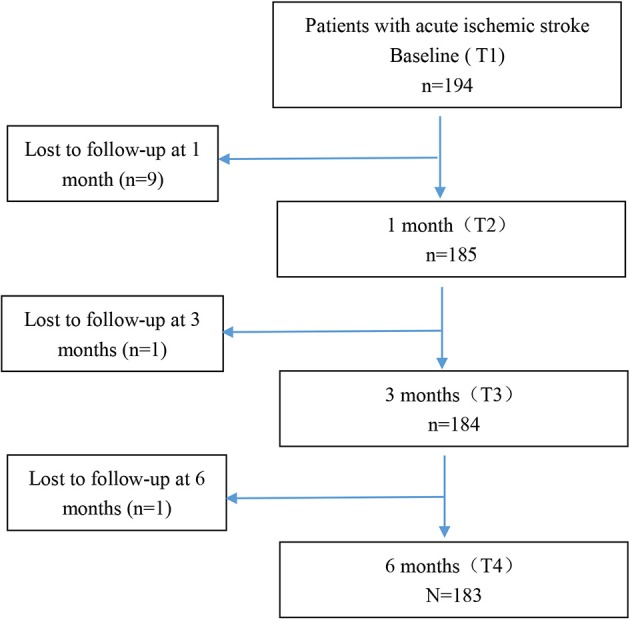
Flowchart of study patients.